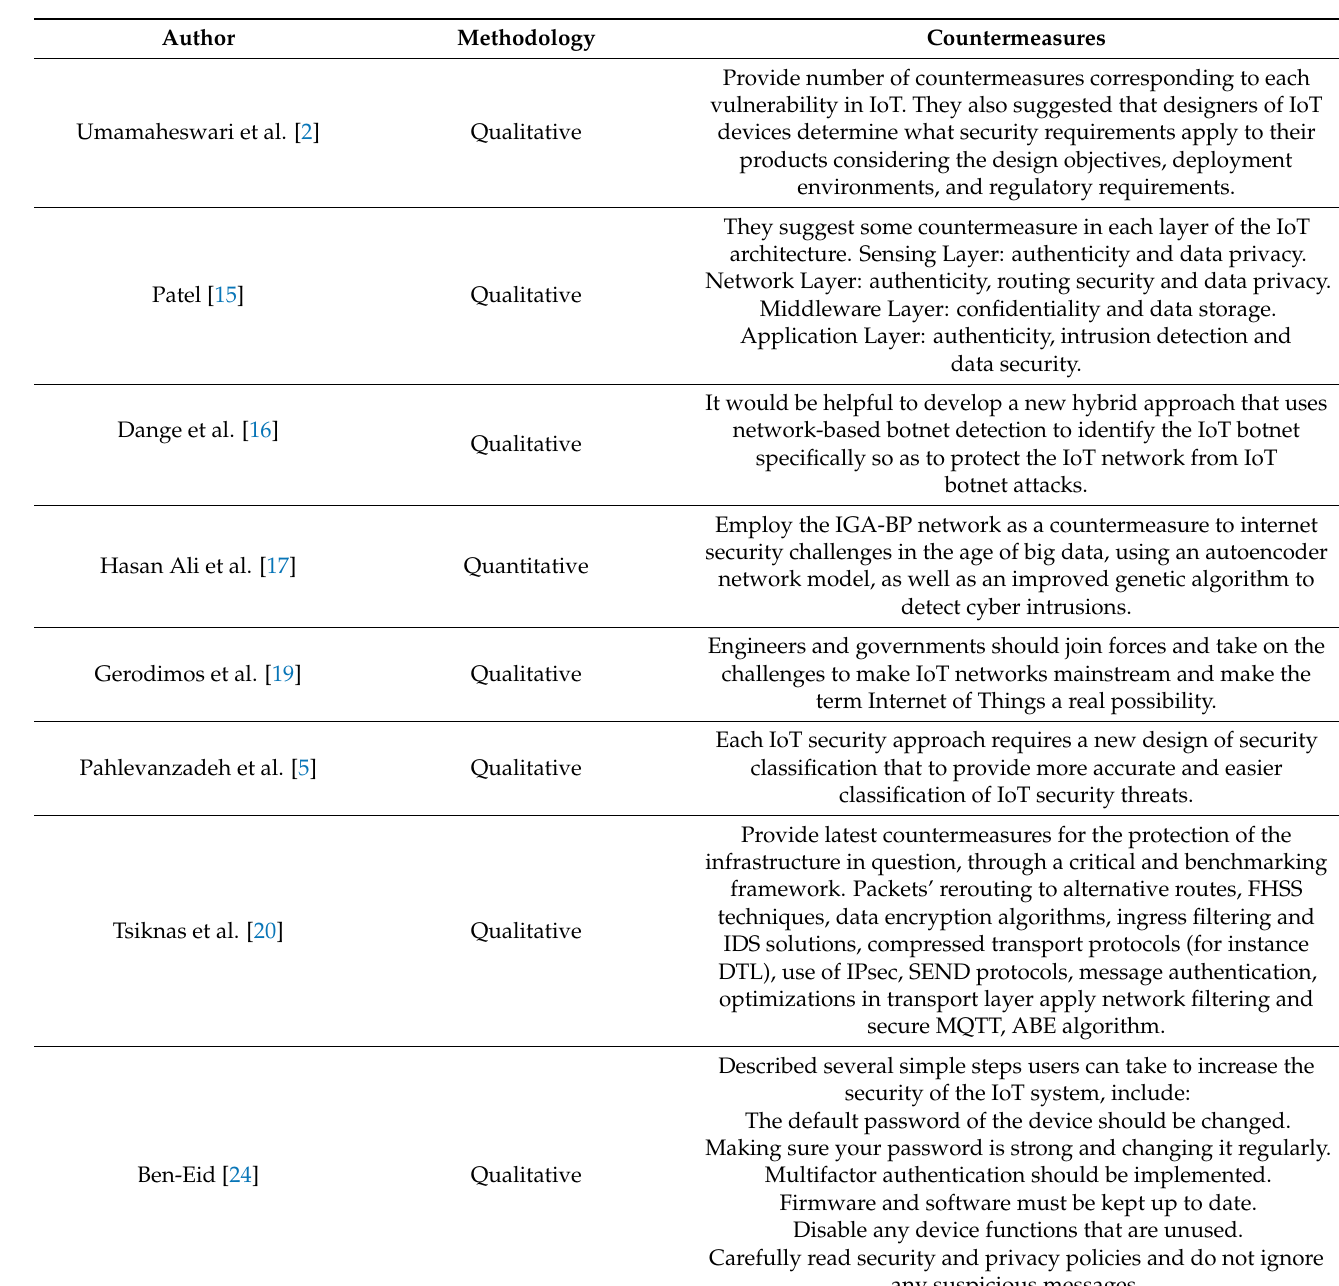
Table 6. Summary of the countermeasures for IoT